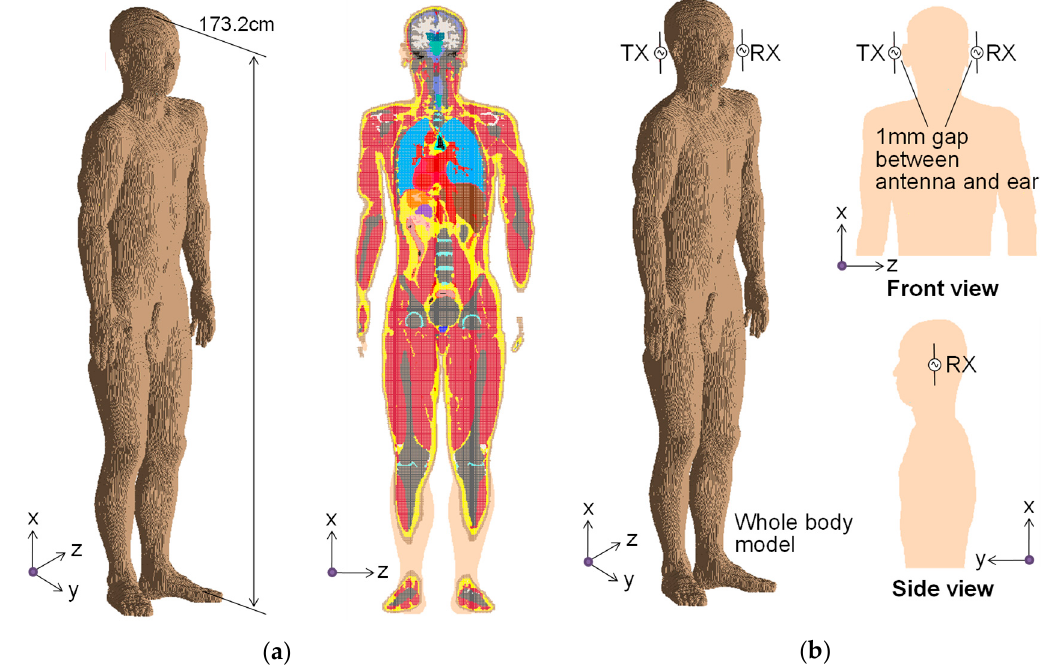
Figure 2. Whole ‐ body human model in the finite difference time domain (FDTD) simulation: ( a ) dimensions and cross ‐ sectional view of the model and ( b ) positions of the transceiver antennas in the 2.45 GHz wireless communication simulation.